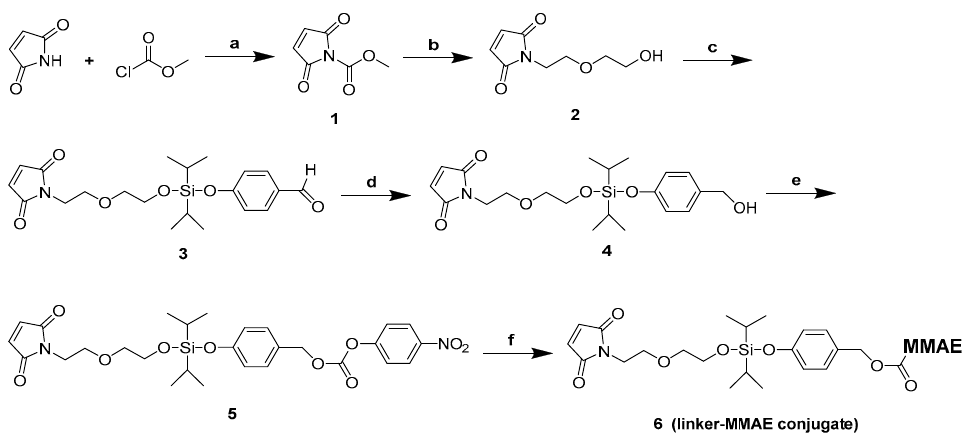
Figure 2. General synthetic route for the linker-MMAE conjugate (compound 6). Reagents and